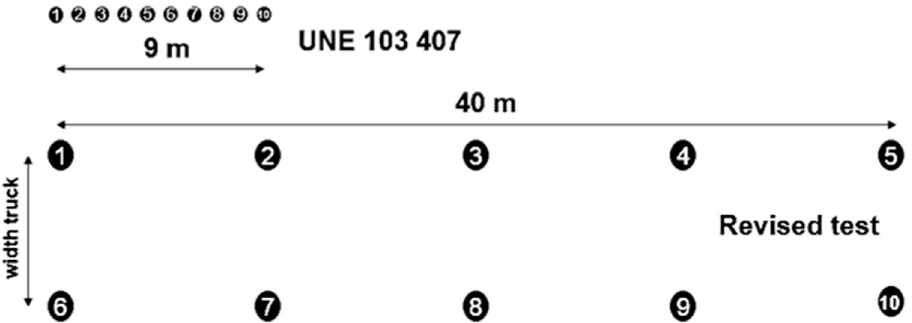
Figure 1. Revised wheel-tracking test measurement points.